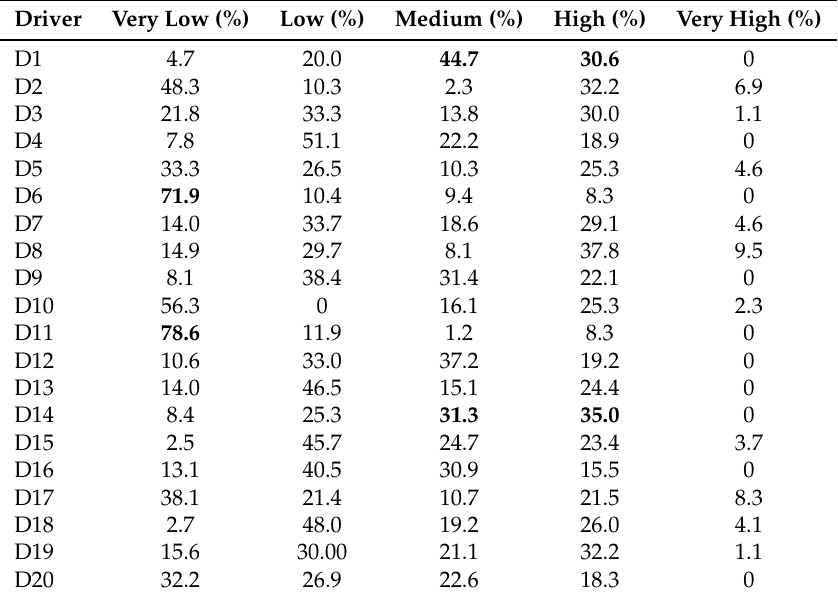
Table 7. Percentage of the route that each driver travels using different fuel-consumption DS (five-cluster